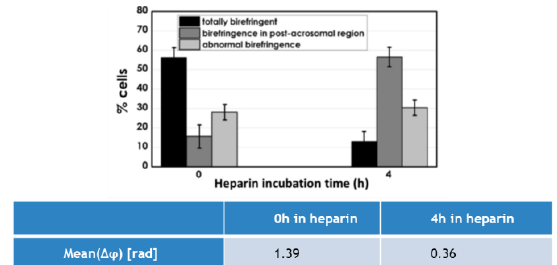
Fig. 2. Distribution of birefringence patterns of sperm from 3 donors exposed to heparin for 0 h (control sample), and 4 h (reacted sample); evaluated mean phase difference Δφ for the two groups of